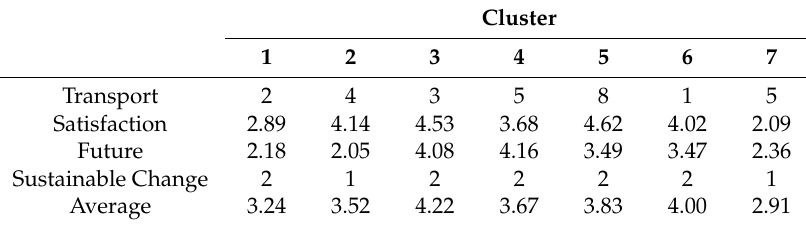
Table 11. Final cluster centres: seven user profiles.